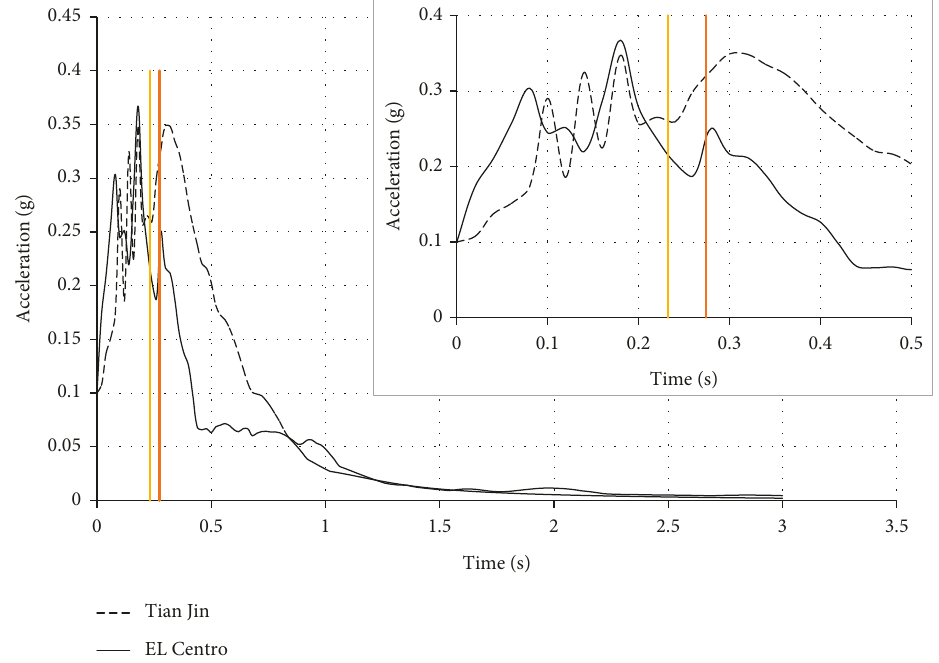
Figure 7: The relative relationship between the base vibration frequency and input response